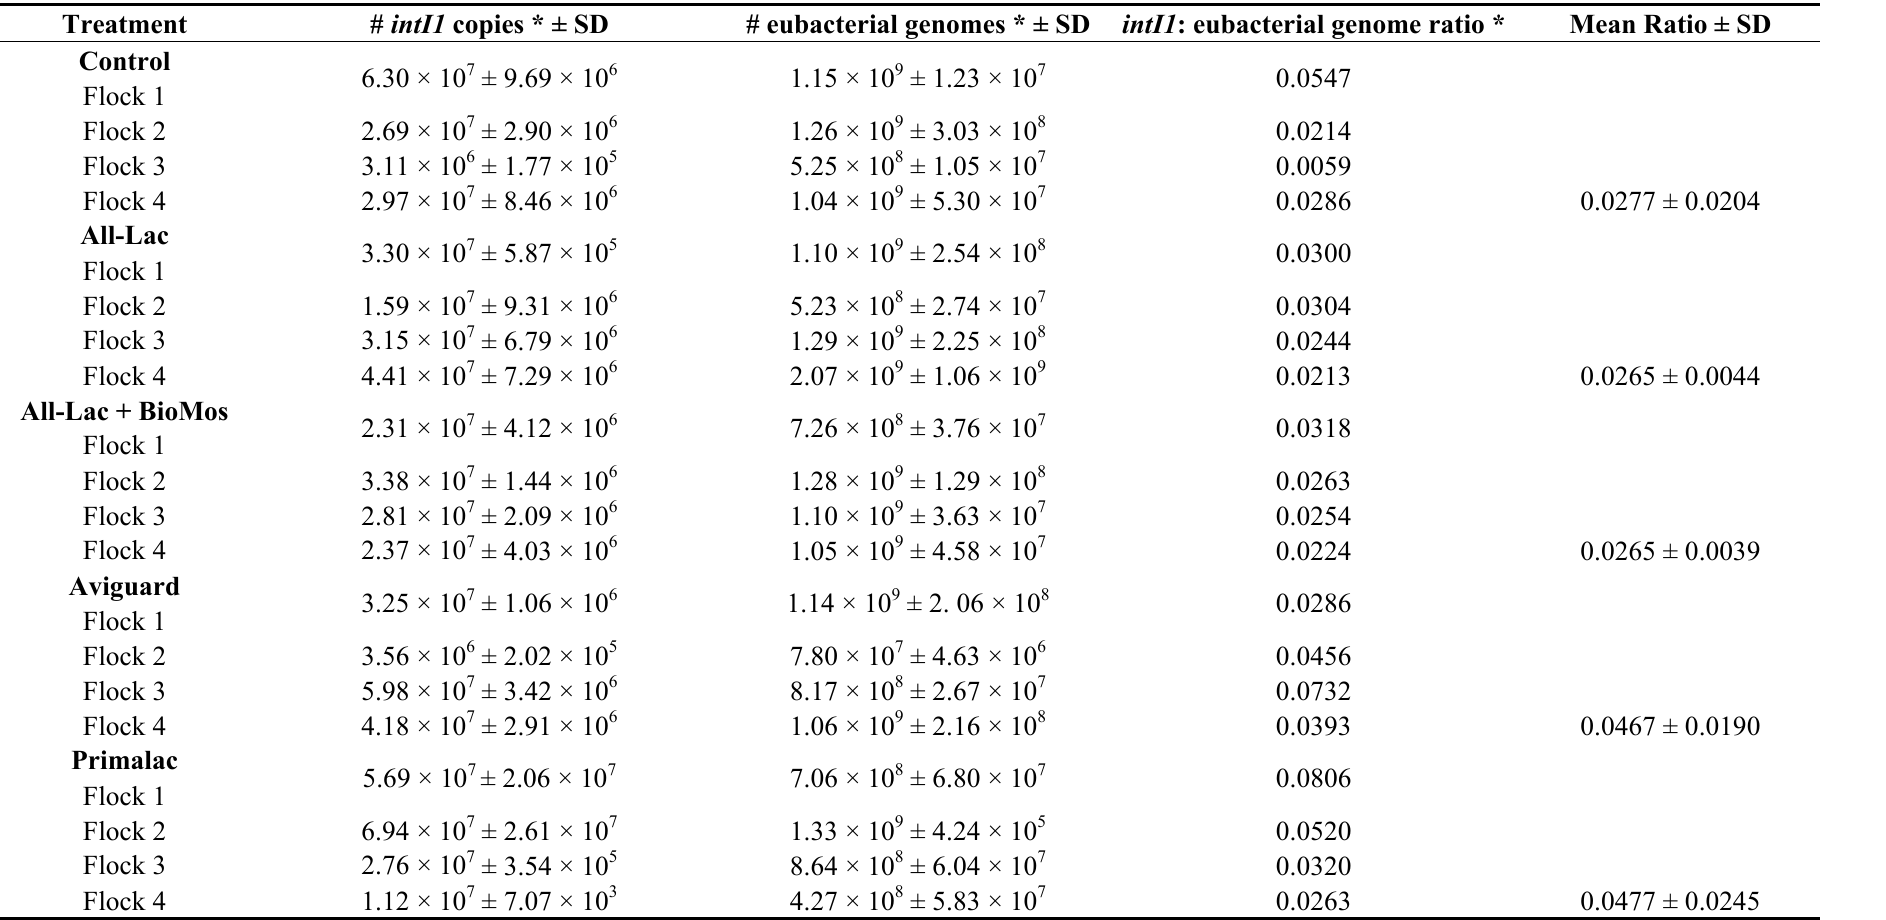
Table 9. Prevalence and abundance of class 1 integron ( intI1 ) genes in litter obtained from four sequential flocks of broiler chickens administered probiotics or prebiotics and reared in research housing. The number (#) of eubacterial genomes and intI1 copies per 25 ng litter DNA was calculated after normalizing the quantitative PCR signal using a control strain and adjusting the signal to reflect genome numbers for the most abundant genera in broiler